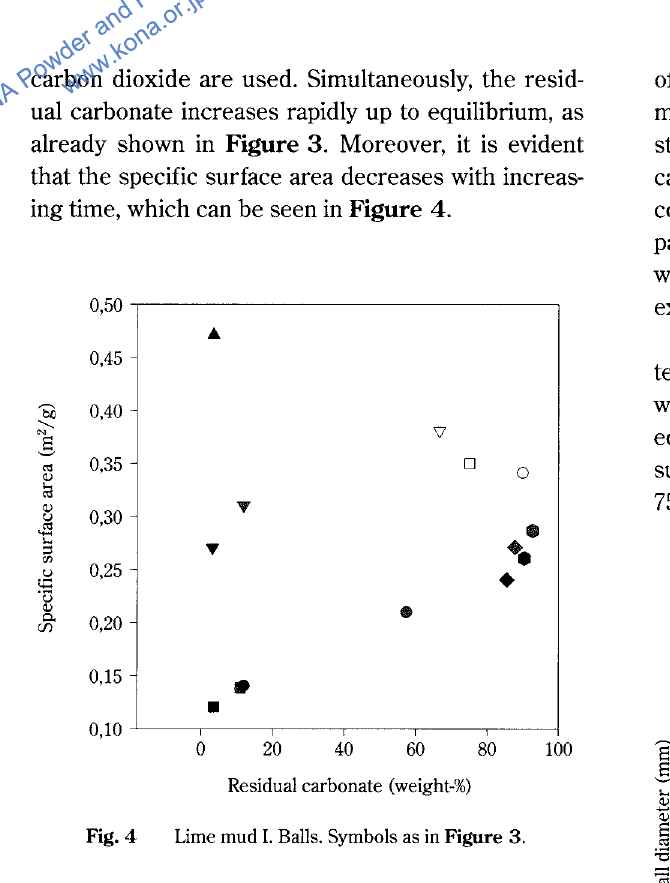
Fig. 4 Lime mud I. Balls. Symbols as in Figure 3.